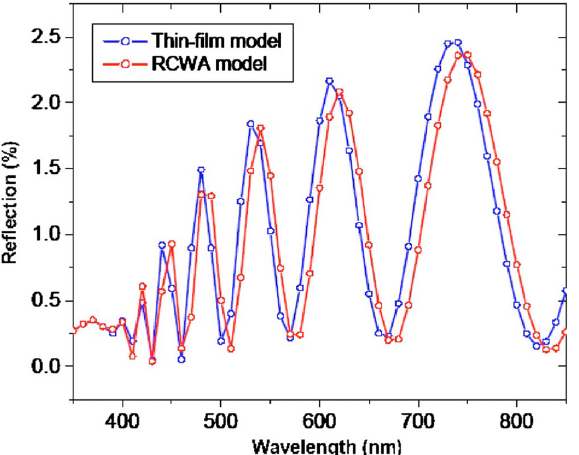
Figure 26. The thin film multilayer model (TMM) and RCWA show very similar results for moth eye structures with 210 nm bases and 800 nm heights. Reprinted with permission from reference [81], Copyright 2008 AIP